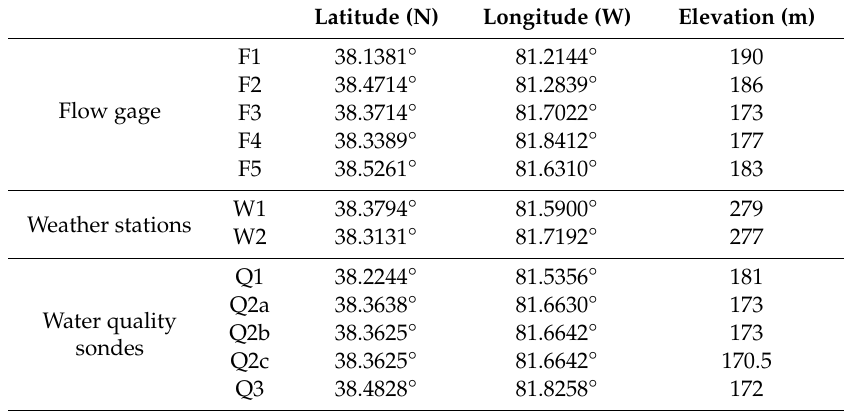
Table 1. Location of flow gages, weather stations and water quality sondes indicated in Figure 1.